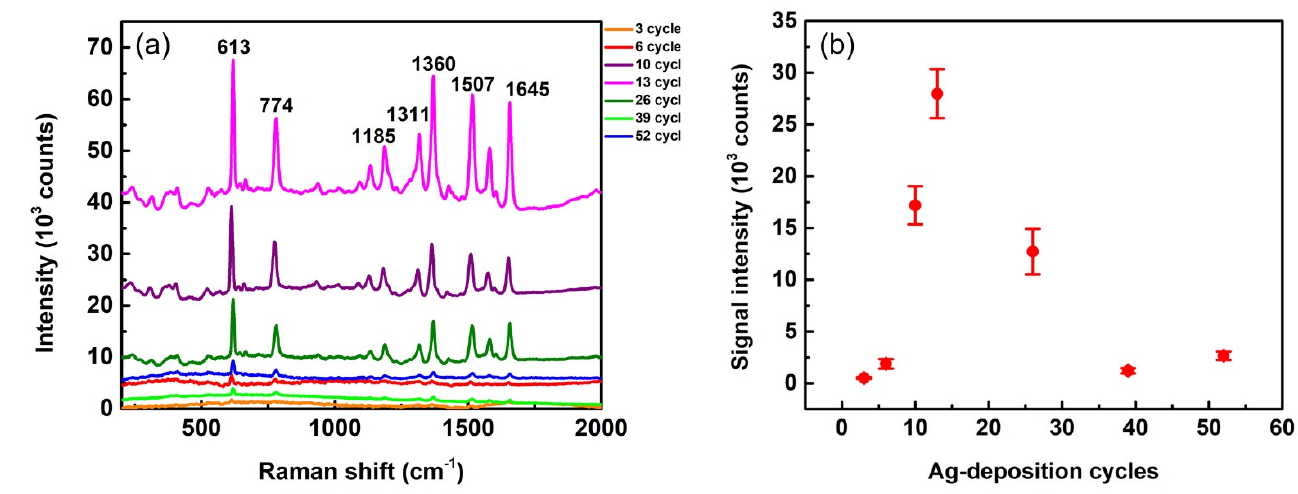
Figure 5. ( a ) SERS spectra from R6G (concentration of 10 − 5 M) on Ag-AAO substrates with different cycles of Ag deposition. The spectra are pristine with neither intensity shift nor background sub- traction. ( b ) Signal intensity of the 613 cm − 1 peak vs. number of Ag-deposition cycles. The laser wavelength of 532 nm, lens of 10 × , and exposure times of 1 s were used for the measurement. In addition to EF, the lowest detection limit of analyte concentrations is another cru- cial factor to judge the quality of SERS substrates. Figure 6a shows the SERS spectra of R6G with varied concentrations. Several Raman peaks of R6G can be observed clearly in the spectra. The most prominent peak of 613 cm − 1 was again used to identify the detection limit of the analyte molecules. This peak can be clearly observed at any concentration be- tween 10 − 11 and 10 − 5 M, as shown in Figure 6a. We used this peak as an indicator to quan- titatively plot signal intensities as functions of Ag-deposition cycles, as shown in Figure 6b. The intensity gradually increases from 900 to 78,000 counts, while the concentration rises from 10 − 11 to 10 − 5 M. The inset in Figure 6b represents an enlarged plot at lower con- centrations to estimate the limit of detection. This study indicates that the Ag-AAO sub- strate could even detect R6G at an extremely low concentration of 10 − 11 M without any ambiguity. This result demonstrates the low detection limit of the proposed SERS sub- strate. These substrates also provide high spatial uniformity as displayed by the error bars shown in Figure 6b. Each error bar is calculated from the standard deviation of 613-cm − 1 peaks in 48 spectra based on three arbitrarily selected Raman mappings of 4×4 square lattices with a lattice constant of 40 μ m. For example, the relative standard deviation (standard deviation divided by signal intensity) for 10 − 5 M is 8%, which indicates a high spatial uniformity. Figure S3 shows the three corresponding mappings for the concentra- tion of 10 − 5 M, which directly display the uniformity of the substrate. The combined results shown in Figure 6a,b indicate that the proposed SERS substrates provide both a low de- tection limit and a high spatial uniformity.